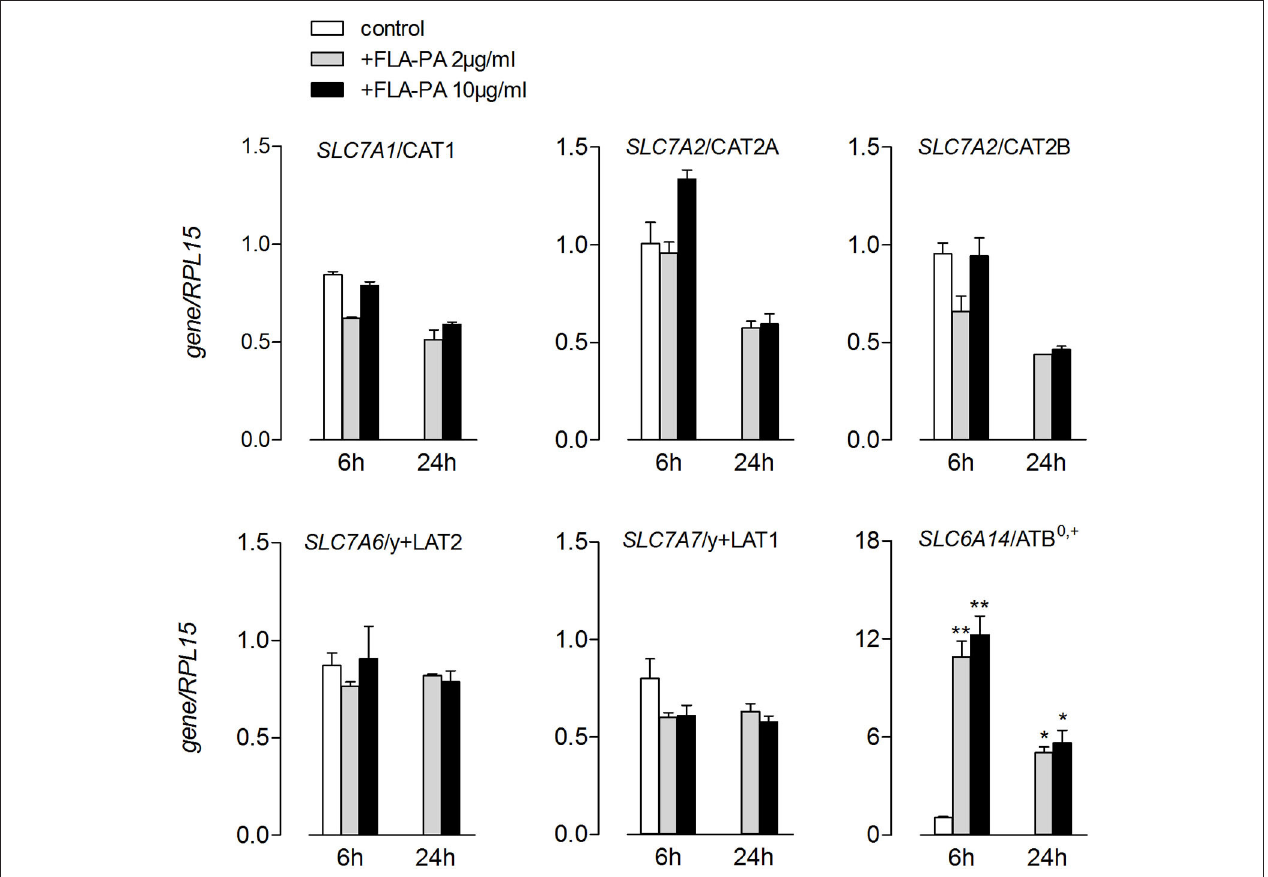
FIGURE 2 | Calu-3 were incubated for 6 and 24h in the presence of the indicated concentrations of FLA-PA; the expression of the indicated genes was then measured by means of real-time quantitative PCR (RT-qPCR) and normalized for the housekeeping gene (RPL15) . Data of three experiments, each performed in duplicate, are presented as mean ± SEM. * p < 0.05, ** p < 0.01 vs.